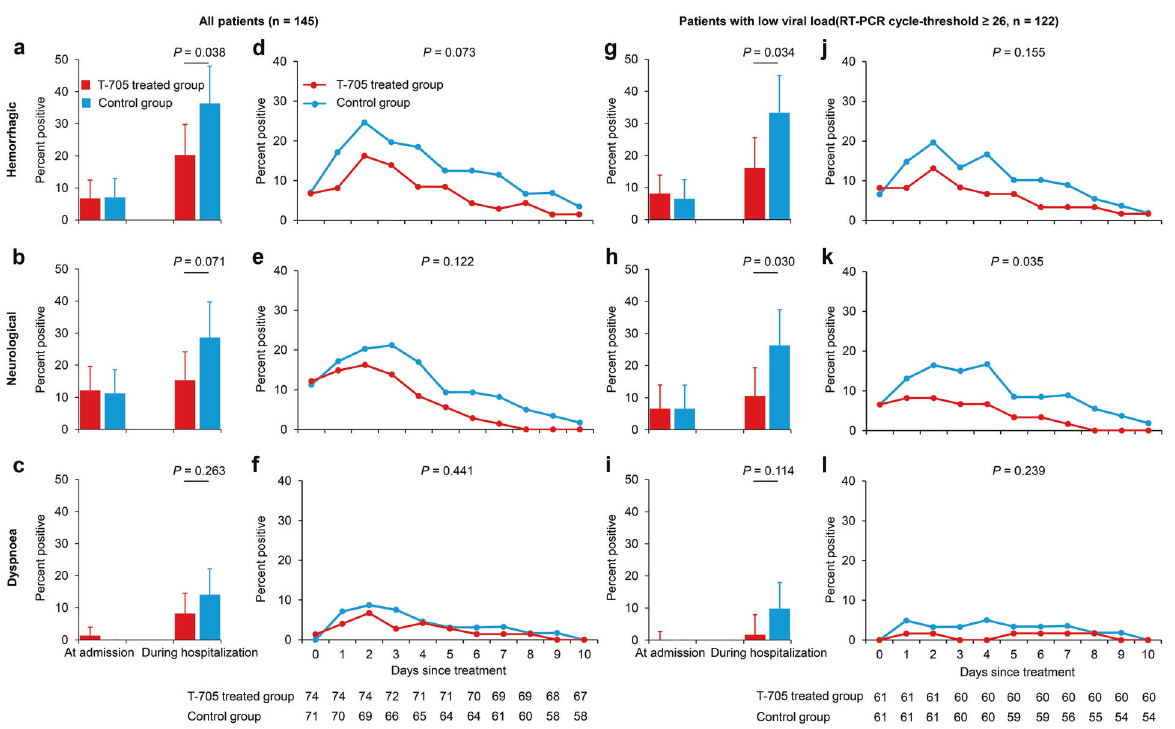
Fig. 6 The percentage of patients presenting severe complications. a – c , g – i The incidences of severe complications at admission and during hospitalization. The percentages of patients presenting hemorrhagic signs ( a , g ), neurological symptoms ( b , h ), and dyspnea ( c, i ) are shown at each time point by treatment arm for all patients ( n = 145) and for patients with low-baseline viral loads (RT-PCR cycle-threshold value ≥ 26, n = 122). The bars indicate the 95% con fi dence intervals (only the upper half is shown). d – f , j – l The daily percentage of severe complications in the patients. The mean percentages of neurological symptoms, hemorrhagic signs, and dyspnea are shown over time for all the patients ( d – f ) and the patients ( j – l ) with low- baseline viral loads (RT-PCR cycle-threshold value ≥ 26). The numbers of patients who contributed to the at-risk population at each time point are shown under the x axis. The difference of these severe complications was analyzed over time (the curves) by using the generalized estimating equation model